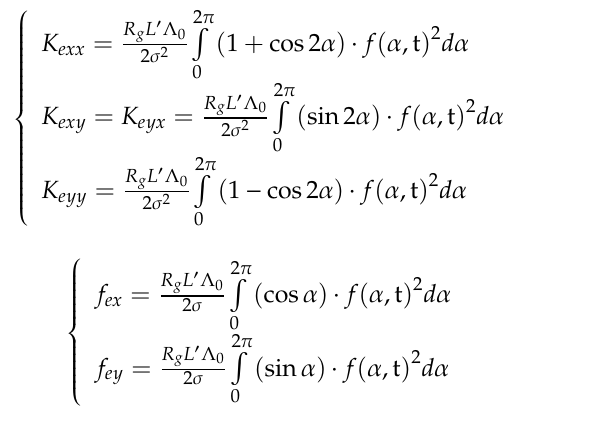
( b ) Figure 6. Vibration response frequency waterfall diagram with misalignment fault: ( a ) Radial vibration; ( b ) Torsional vibration. 3.3. Single Short-Circuit Fault Figure 7 is the frequency waterfall diagram of the generator rotor system in case of 2%, 4%, 6%, 8%, and 10% stator short-circuit fault. With the increase of the stator short-circuit fault degree, in addition to 1 harmonic frequency in the radial vibration frequency, the 3 and 5 harmonic components are constantly highlighted, the amplitude of each frequency is also increasing. The 1 harmonic is the main component of the radial vibration frequency. The 2 harmonic frequency component appears in the torsional vibration, and it increases linearly with the growth of the short-circuit coefficient. This is because the short-circuit current in the stator will induce a 2 harmonic frequency excitation current